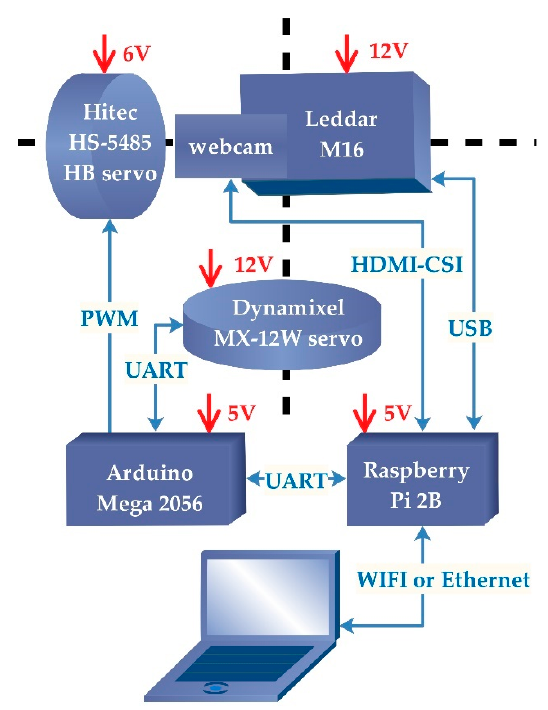
Figure 2. Hardware components and connections of the FSS. PWM: Pulse width modulation. UART: Universal asynchronous receiver / transmitter. CSI: Camera serial interface. Table 2. Major hardware specifications.